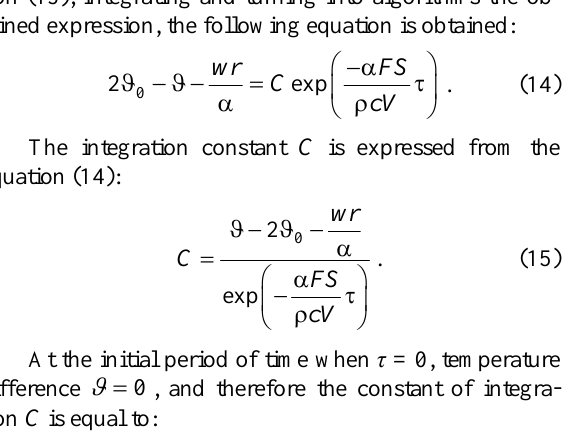
Fig. 2. Plant leaf thickness in a transverse section. Explanations are given in the